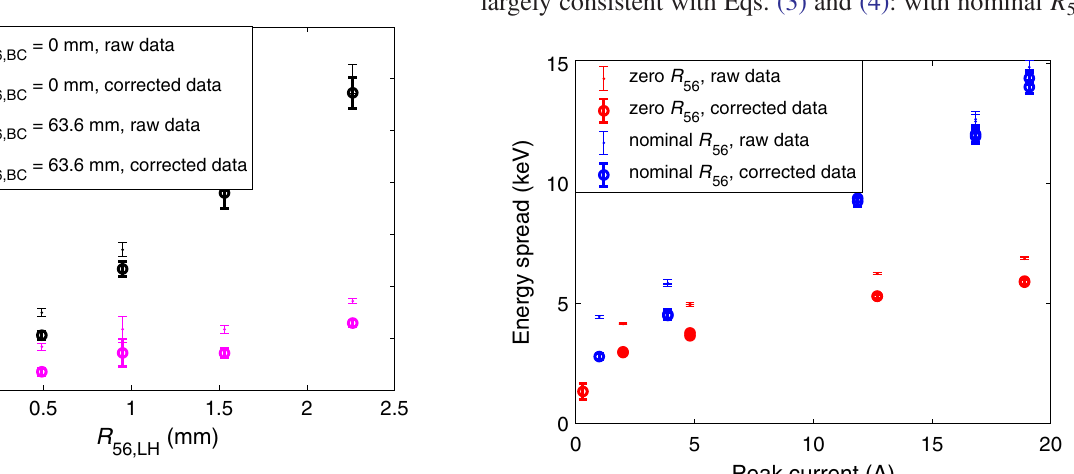
FIG. 4. Energy spread measurements as a function of the peak LH current of the electron beam for two different R 56